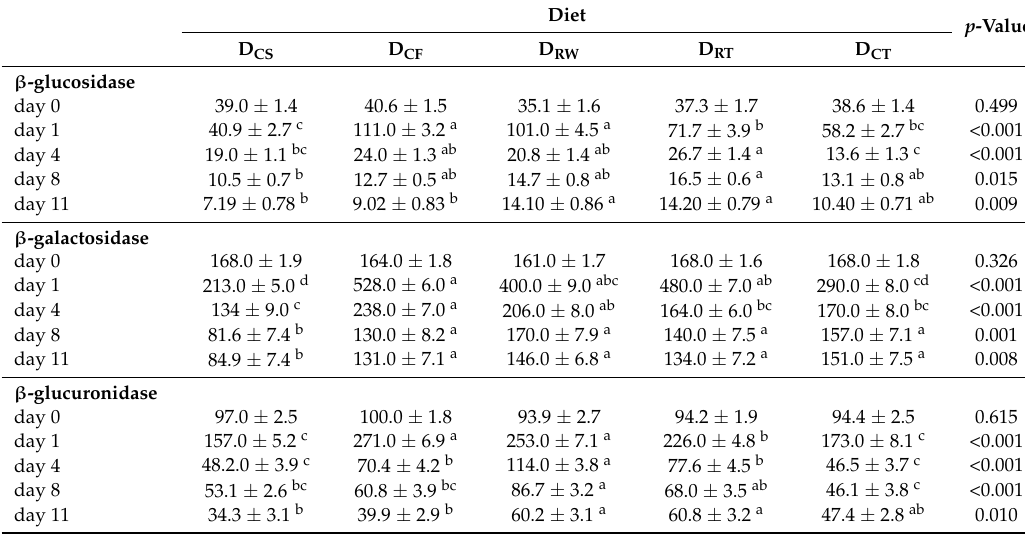
Table 2. Activity of the selected bacterial enzymes in the rats’ feces during the experiment. Data are expressed as mean ± SEM, n = 8.